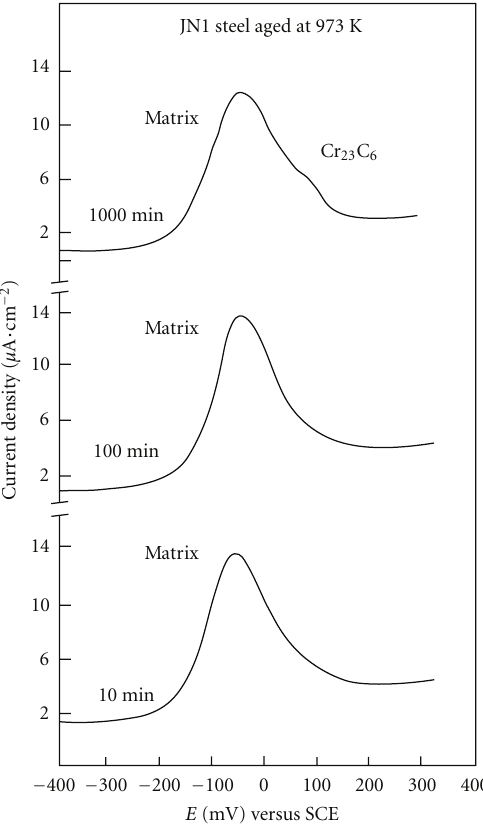
Figure 6: Anodic polarization curves of JN1 steel aged at 973K for 10, 100, and 1000